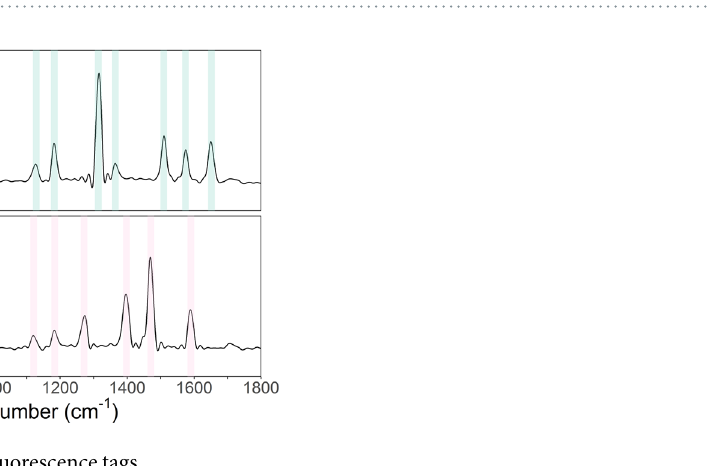
Figure 1. Schematic illustration of the PCR-SERS method for the detection of EGFR mutations in blood plasma.